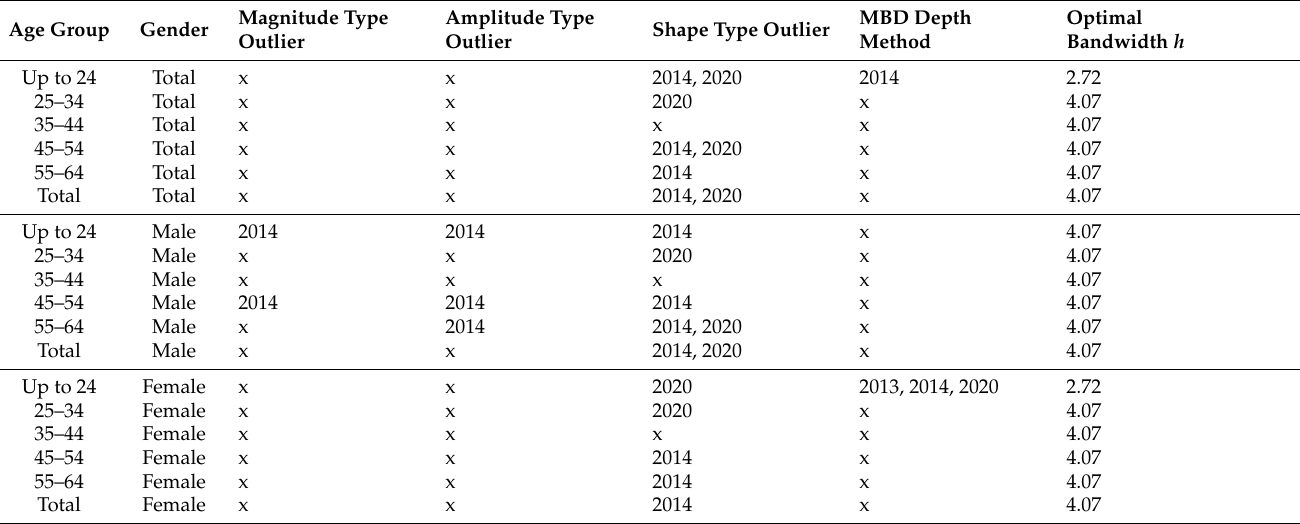
Table A3. Functional data methods for outlier